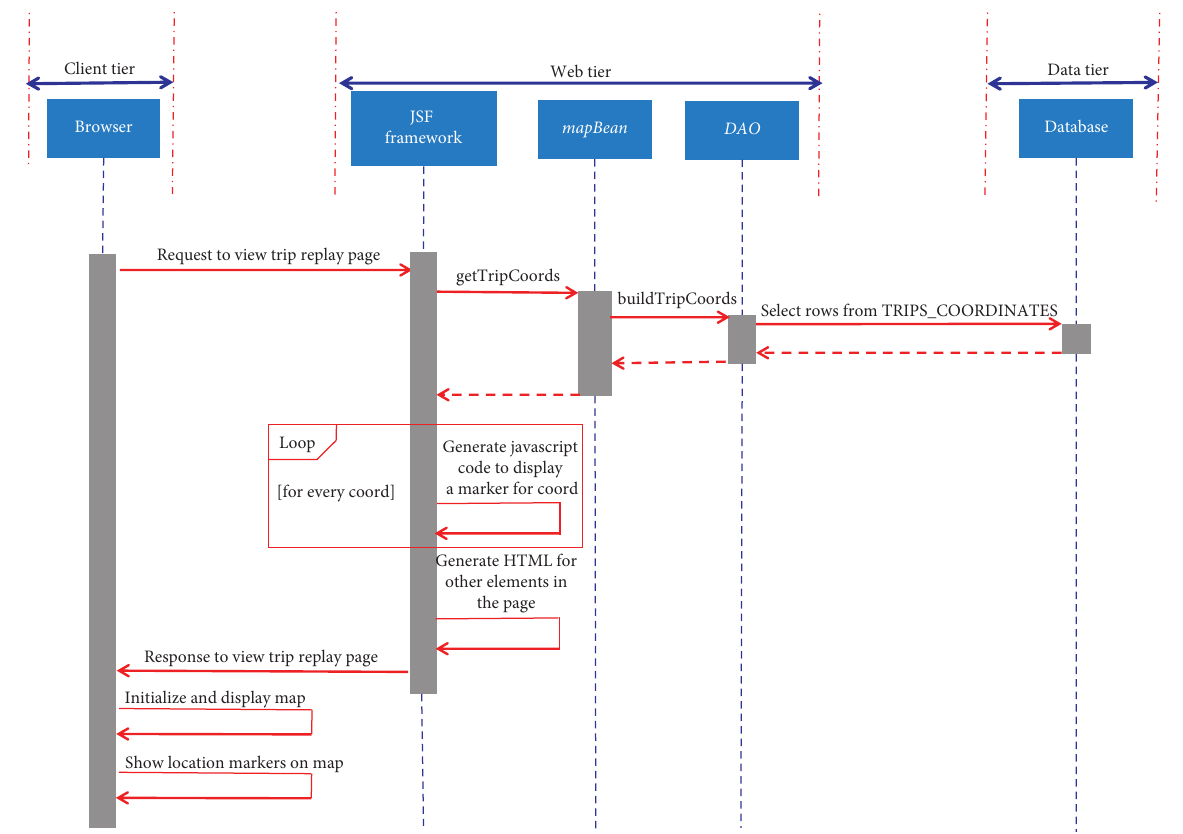
Figure 16: The sequence diagram for the replay bus trip code interactions.